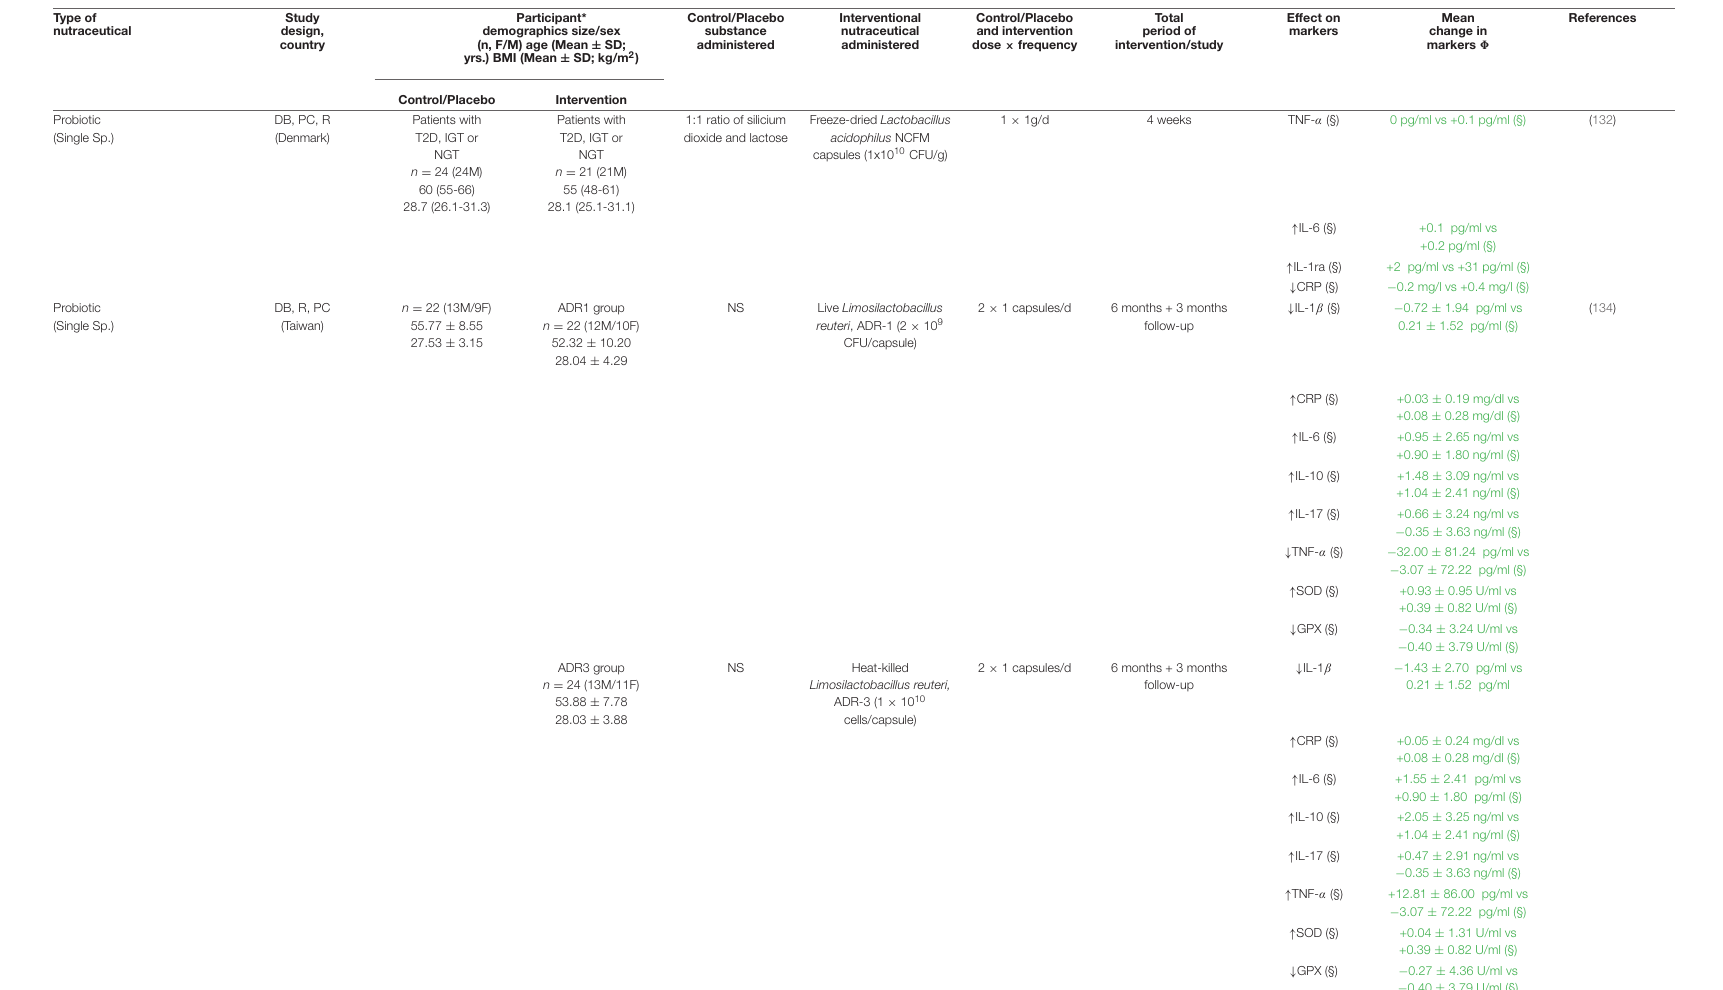
TABLE 2 | Studies investigating the effect of probiotics on markers of inflammation and oxidative stress in T2D. Typeof